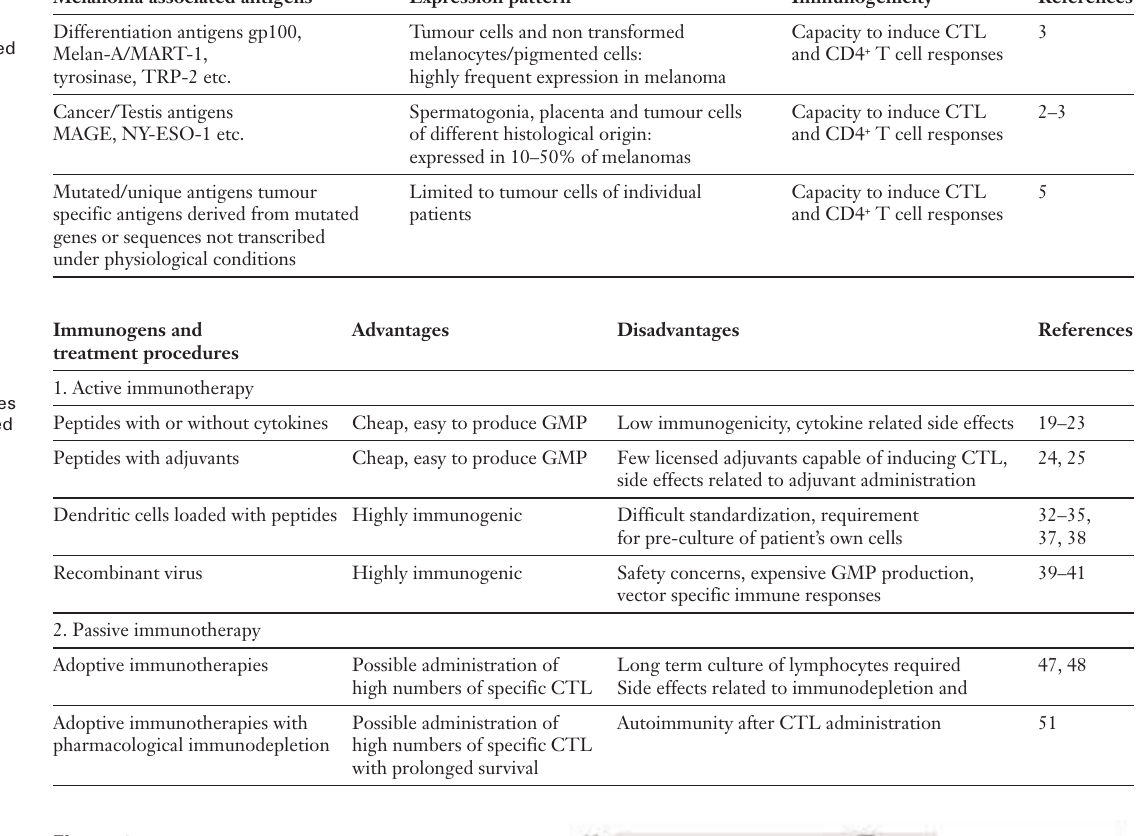
Overview of clinical trials in metastatic melanoma 1992–2004. Data refer to published clinical trials as reported in PUBMED public literature database under the heading: “melanoma and vaccination” with the “clinical trial” limit. Trials taking advantage of re- combinant virus were added. Note that data from individual trials were at times reported in more than one work, and thus the number of trials reported here is lower than that of entries in PUBMED. Trials involving undefined antigens, e.g. tumour cells, cellular hybrids, heat shock proteins or exo- somes are outside the scopes of this